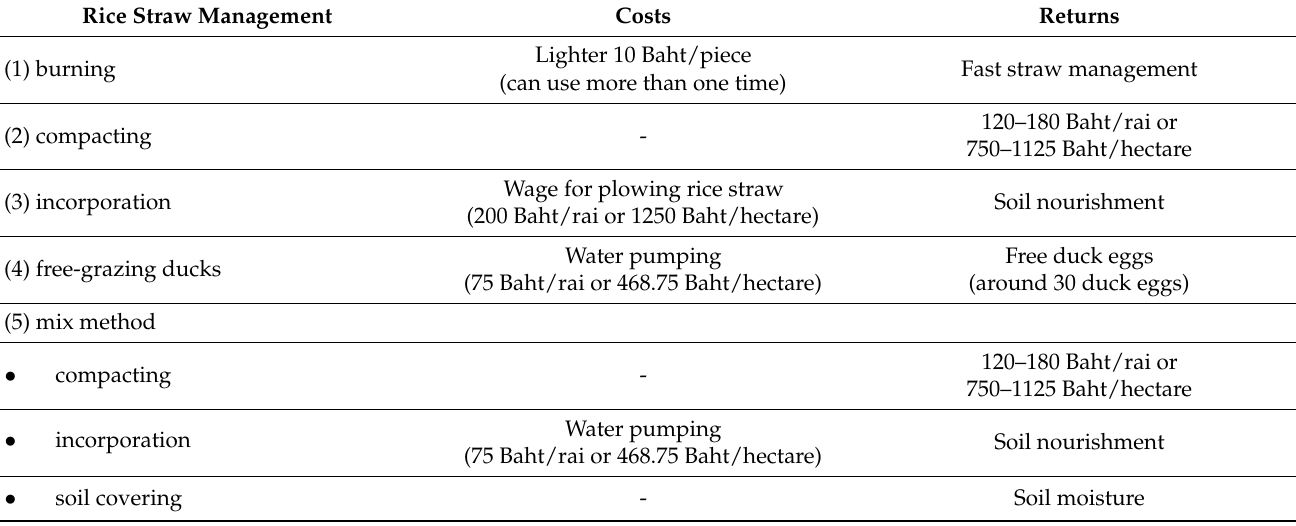
Table 3. Average costs and returns for each method of rice straw